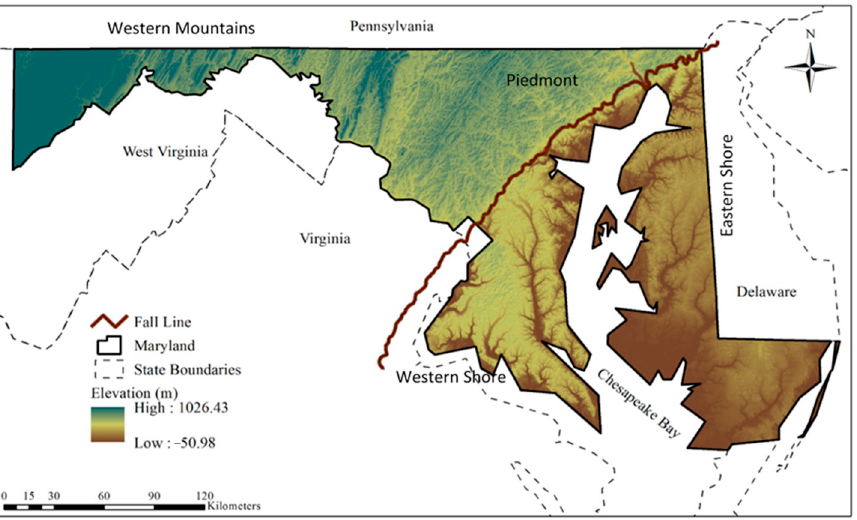
Figure 1. Map of the study area, showing the main three regions and Fall Line within the state of Maryland.